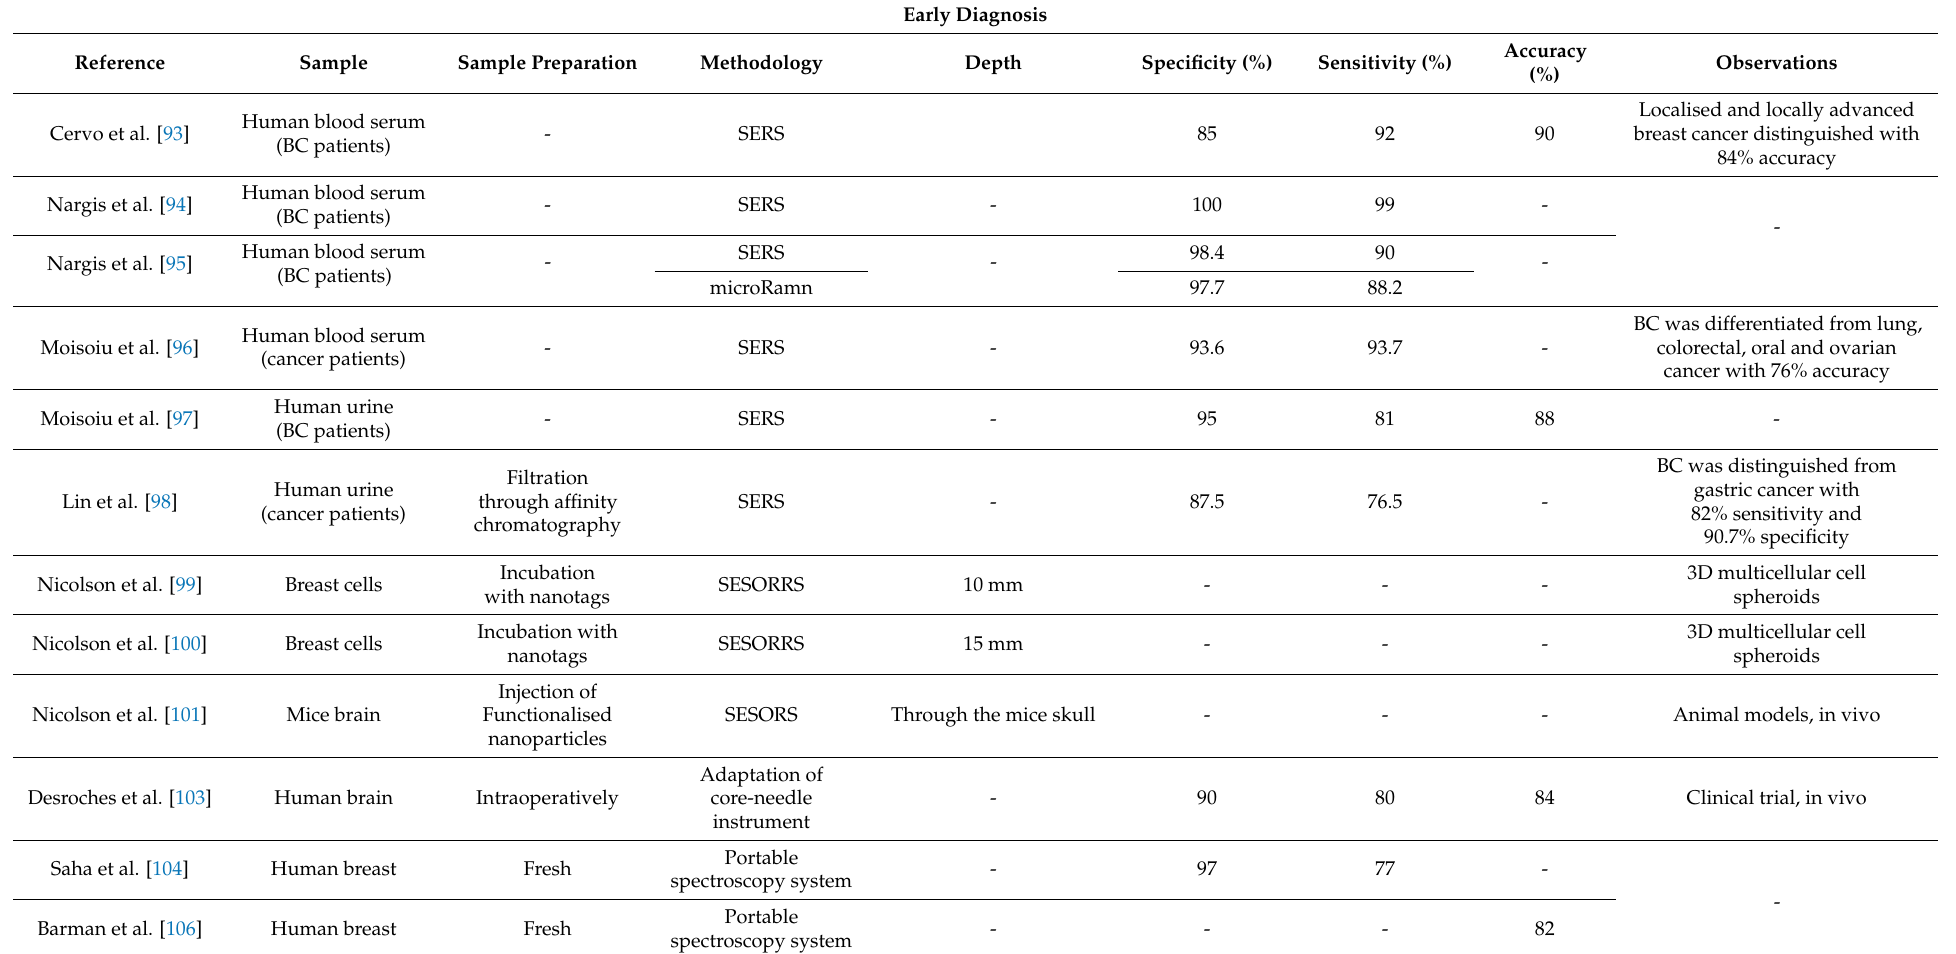
Table 1. Summary of the research studies included in this review article, performed with Raman spectroscopy, according to the type of sample, sample preparation, methodology and specifications